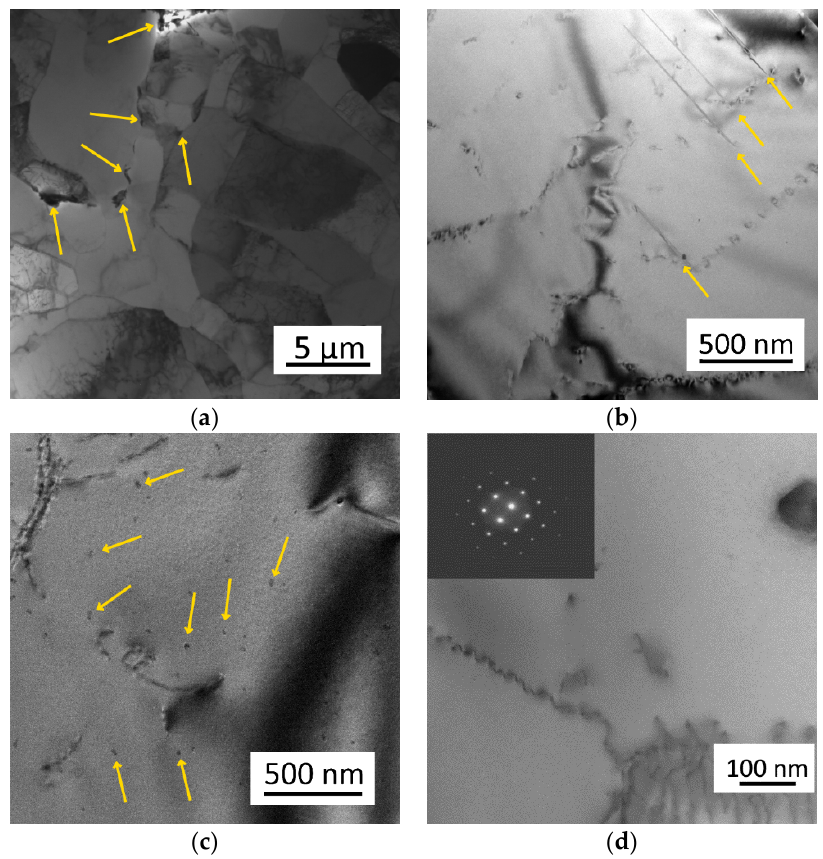
Figure 4. Transmission electron microscopy (TEM) analysis of the as cast strip of the Al-Li-Cu-Mg-Zr-Sc alloy. Bright field images showing a decoration of grain boundaries by primary phase particles ( a ), rare precipitates of Al 2 CuMg phase ( b ), and Ag particles ( c ). Higher magnification close to [100] Al-orientation ( d ). The inset shows diffraction pattern from [100] Al-zone with visible fine forbidden reflections and streaks.